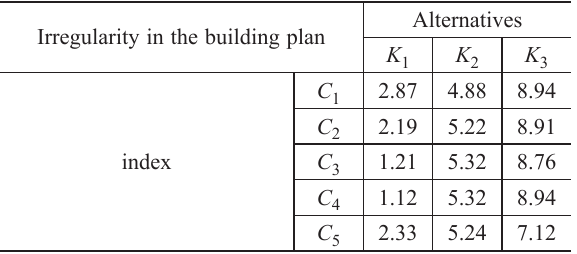
Table 17. Averages of experts’ scores for alternatives of shape of surface of exterior shell within the major indexes Surface shape of exterior shell